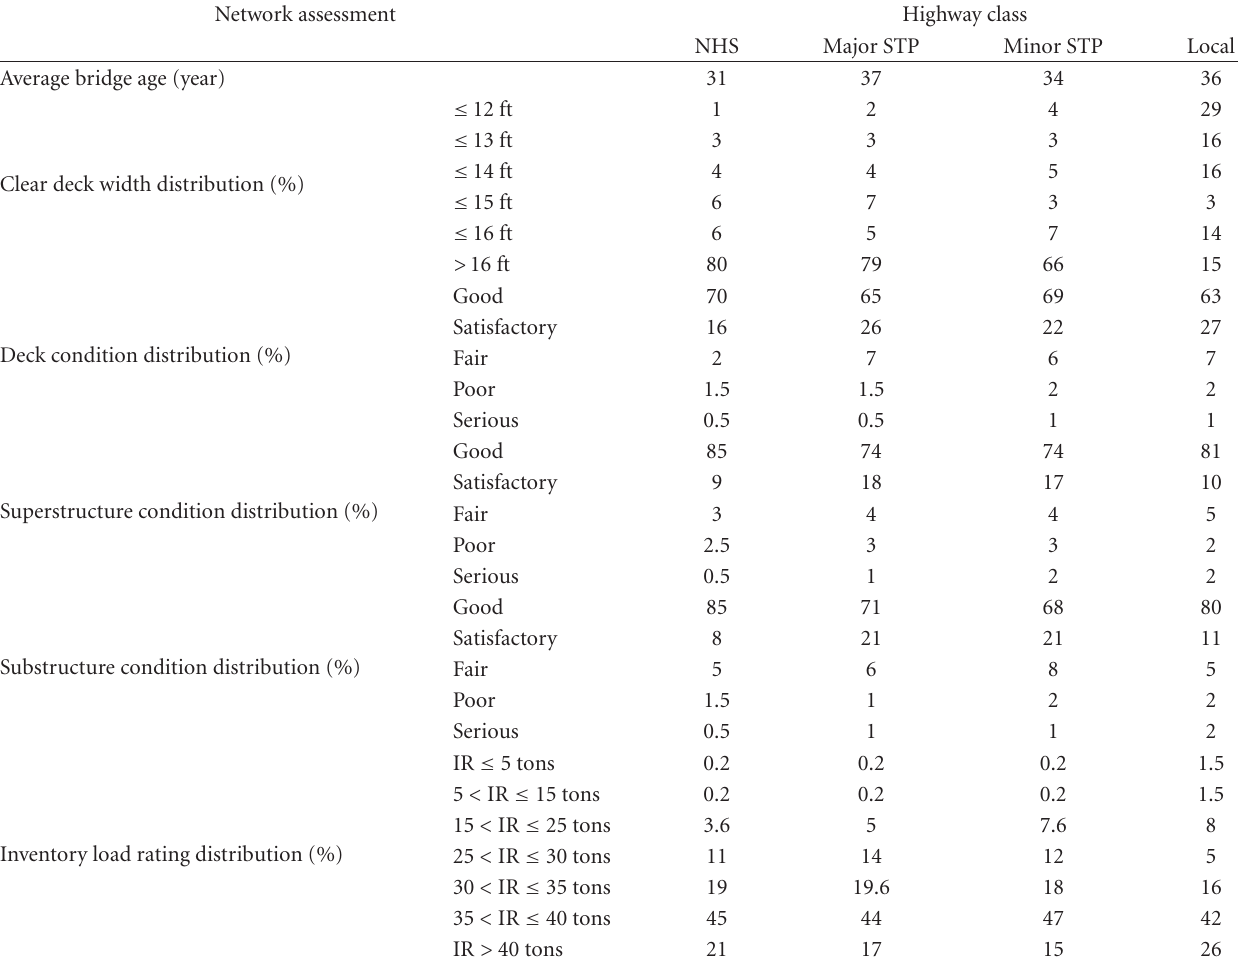
Table 2: Indiana bridge inventory characteristics from the last